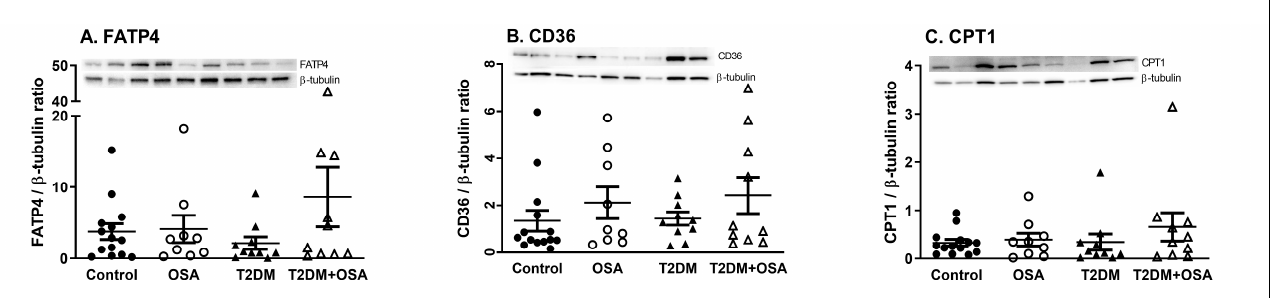
Figure 2. Protein expression of FATP4, CD36, and CPT1 in muscle biopsies. Western blot and densitometric analyses were performed to quantify the expression of ( A ) fatty acid transport protein 4 (FATP4), ( B ) platelet glycoprotein 4 (CD36), and ( C ) carnitine-palmitoyl transferase I (CPT1), relative to the expression of β -tubulin protein. Control (nondiabetic persons without sleep apnea syndrome), OSA (nondiabetic persons with severe sleep apnea syndrome), T2DM (type 2 diabetes mellitus patients without severe sleep apnea syndrome), and T2DM + OSA (type 2 diabetes mellitus patients with severe sleep apnea syndrome). Data are presented as individual values and error bars displaying the mean ± SEM; an ANOVA test was performed to assess differences between the